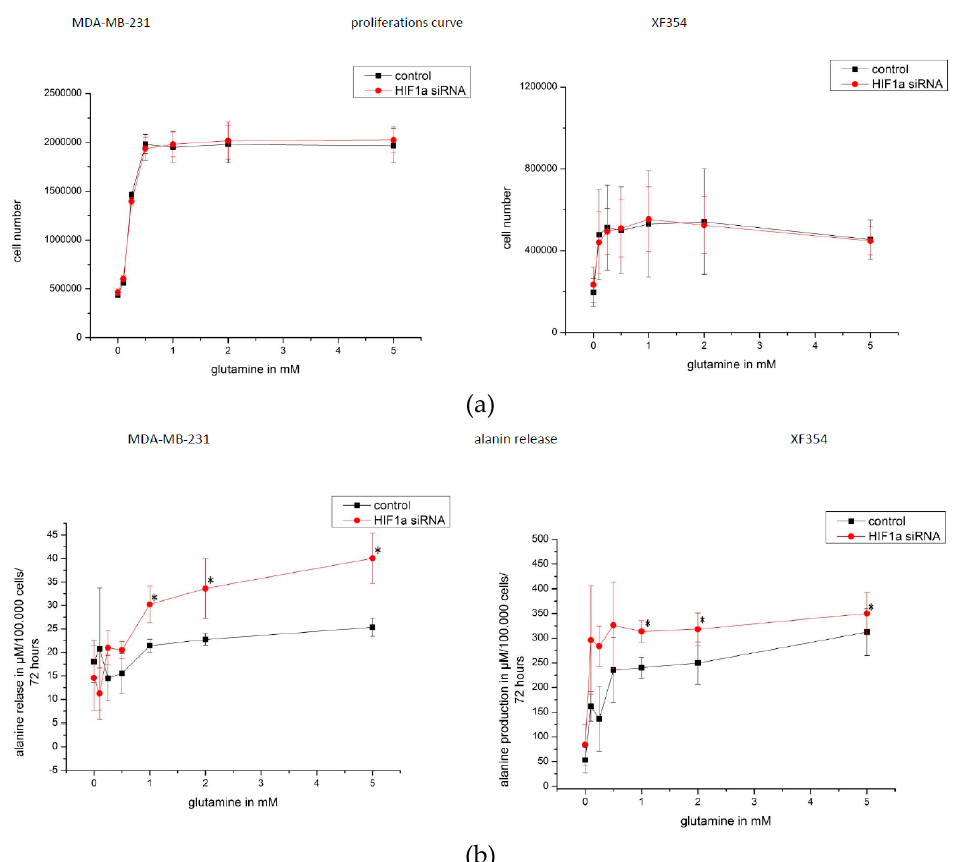
Figure 11. ( a ) Glutamine ‐ mediated effects on proliferation and alanine release in HIF1 α‐ silenced tumor cells. Cell proliferation assay for MDA ‐ MB ‐ 231 and XF354 cells were performed with a total of 200,000 cells, which were cultivated for 72 h with different levels of glutamine 0 ‐ 5 mM in 4 mL of medium (RPMI or DMEM each with glucose). The number of cells were counted. MDA ‐ MB ‐ 231 cells reached a maximum number at approximately 2,000,000 cells (cultivated in RPMI), and XF354 (cultivated in DMEM) reached a maximum number at approximately 550,000 cells within 72 h of proliferation, respectively. The application of glutamine increased the proliferation of both cells, whereas the treatment with HIF1 α‐ specific siRNA did not. ( b ) The release of alanine, a second waste product of glutamine catabolism, was determined for the MDA ‐ MB ‐ 231 and XF 354 cells, which were cultivated for 72 h with different levels of glutamine (0–5 mM in 4 mL of medium). In the MDA ‐ MB ‐ 231 treated with lower concentrations of glutamine cells ( ≤ 0.5 mM glutamine), the relative alanine level was approximately 20 μ M/100,000 cells as compared to the cells that were cultivated with higher levels of glutamine (>1 mM), for which the alanine level was greater. In the presence of 1–5 mM glutamine, a significant increase in the alanine level released by the cells was found for HIF1 α -silenced cells compared to the amount of released alanine from the control cells. After glutamine ( > 0.1 mM) was added to the XF354 cells, the release of alanine was increased such that it was in the range from 100 µ M to 300 µ M / 100,000 cells within 72 h, while the addition of 1–5 mM glutamine led to a significant increase in the alanine level released from cells that were treated with HIF1 α -specific siRNA compared to amount of alanine released from the control cells. After 72 h of cultivation in a medium without alanine, the MDA-MB-231 released the maximum alanine concentration at approximately 930 µ M, and for XF354 cells, a maximum of 2000 µ M alanine was released after 72 h of cultivation. The application of HIF1 α -specific siRNA had a significant e ff ect on the amount of alanine released at glutamine levels > 1